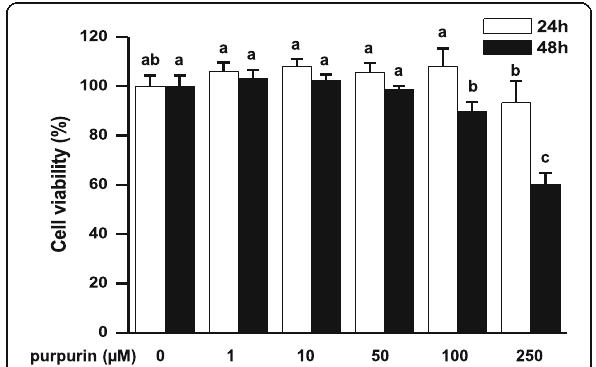
Fig. 3 Cytotoxicity of purpurin on the murine 3T3-L1 pre-adipocyte cell line. Cells were cultured in the presence of purpurin (1, 10, 50, 100, and 250 μ M) for 24 and 48 h. After treatment, cell survival was measured by the MTT assay. Data are expressed as the mean ± SD of triplicate experiments. Bars sharing a common letter are not significantly different at p <